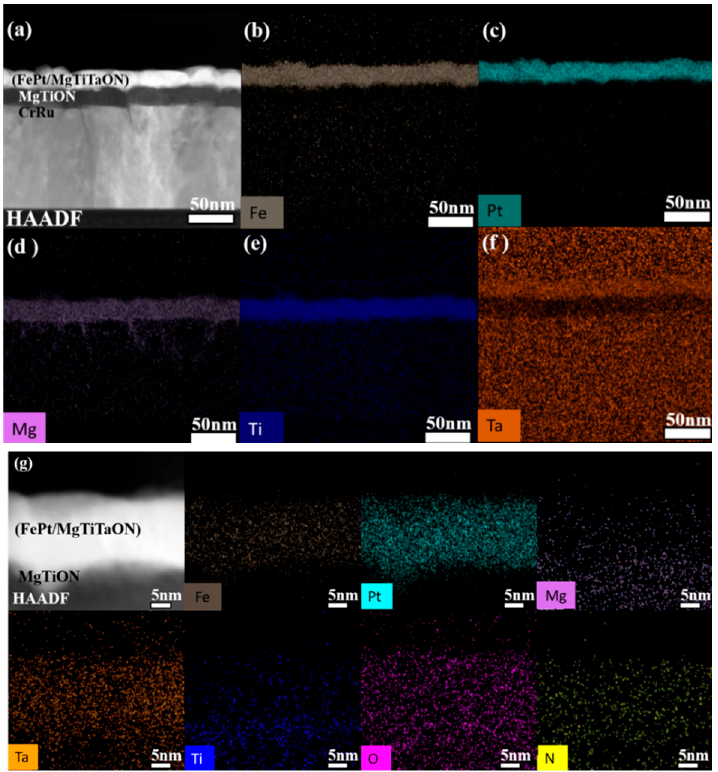
Figure 7 . Element mapping of FePt(6 nm)/[MgTiTaON(1 nm)/FePt(4 nm)] 2 /MgTiON film, ( a ) Dark field image; ( b–f ) mapping image of ( b ) Fe; ( c ) Pt; ( d ) Mg; ( e ) Ti and ( f ) Ta; ( g ) magnified images of FePt/MgTiTaON layers.